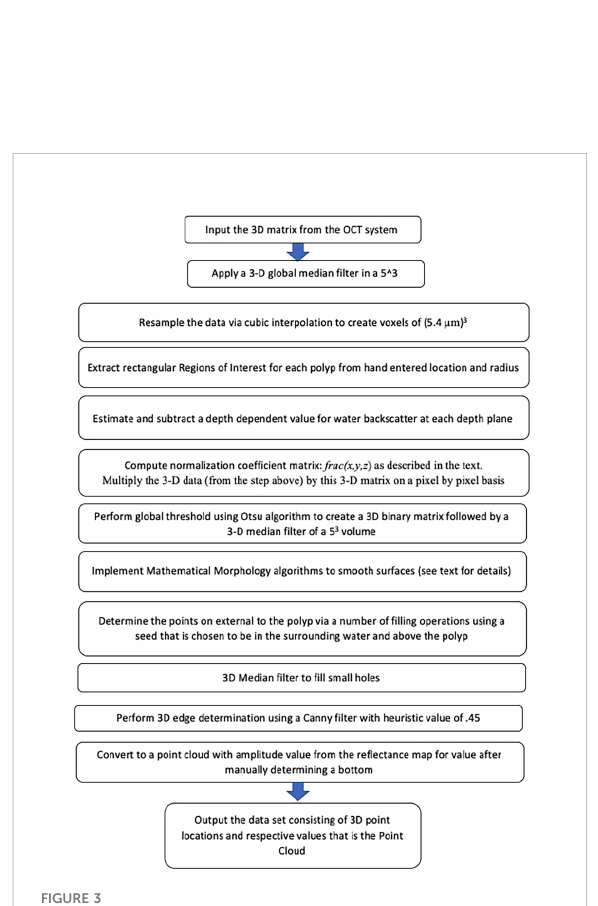
FIGURE 3 A summary of the custom MATLAB code that was used to create point clouds from the input OCT 3D